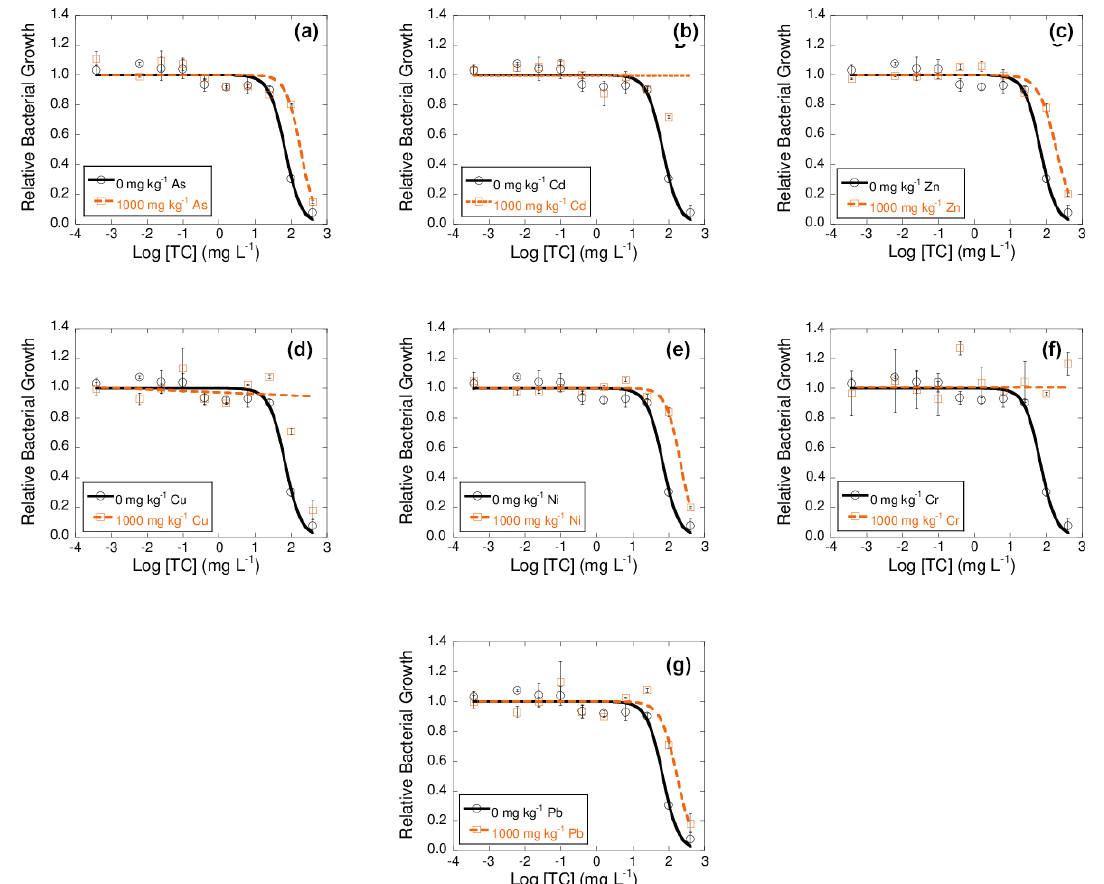
Figure 2. Dose–response curves obtained after the addition of 10 different concentrations of tetracycline (TC) to bacterial suspension ex- tracted from soil samples polluted with 1000mgkg − 1 of As (a) , Cd (b) , Zn (c) , Cu (d) , Ni (e) , Cr (f) , or Pb (g) , each of them added separately, after 42d of incubation. Black lines represent the dose–response curves obtained for the unpolluted soil (control), and dashed orange lines are dose–response curves for soils polluted with 1000mgkg − 1 of one of the heavy metals. Average values ( n = 3) with coefficients of variation always < 5%.